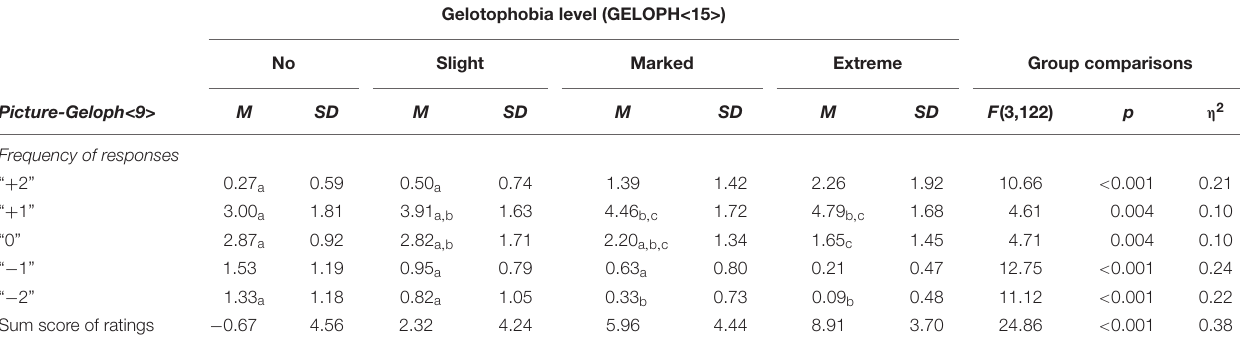
TABLE 4 | Frequency of types of responses and the sum score of the Picture-Geloph<9> as a function of level of gelotophobia (Study